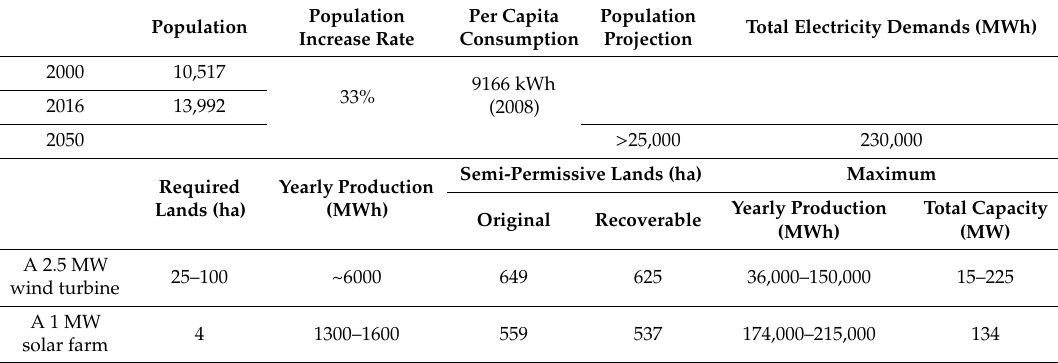
Table 3. Power demands and land-based potential